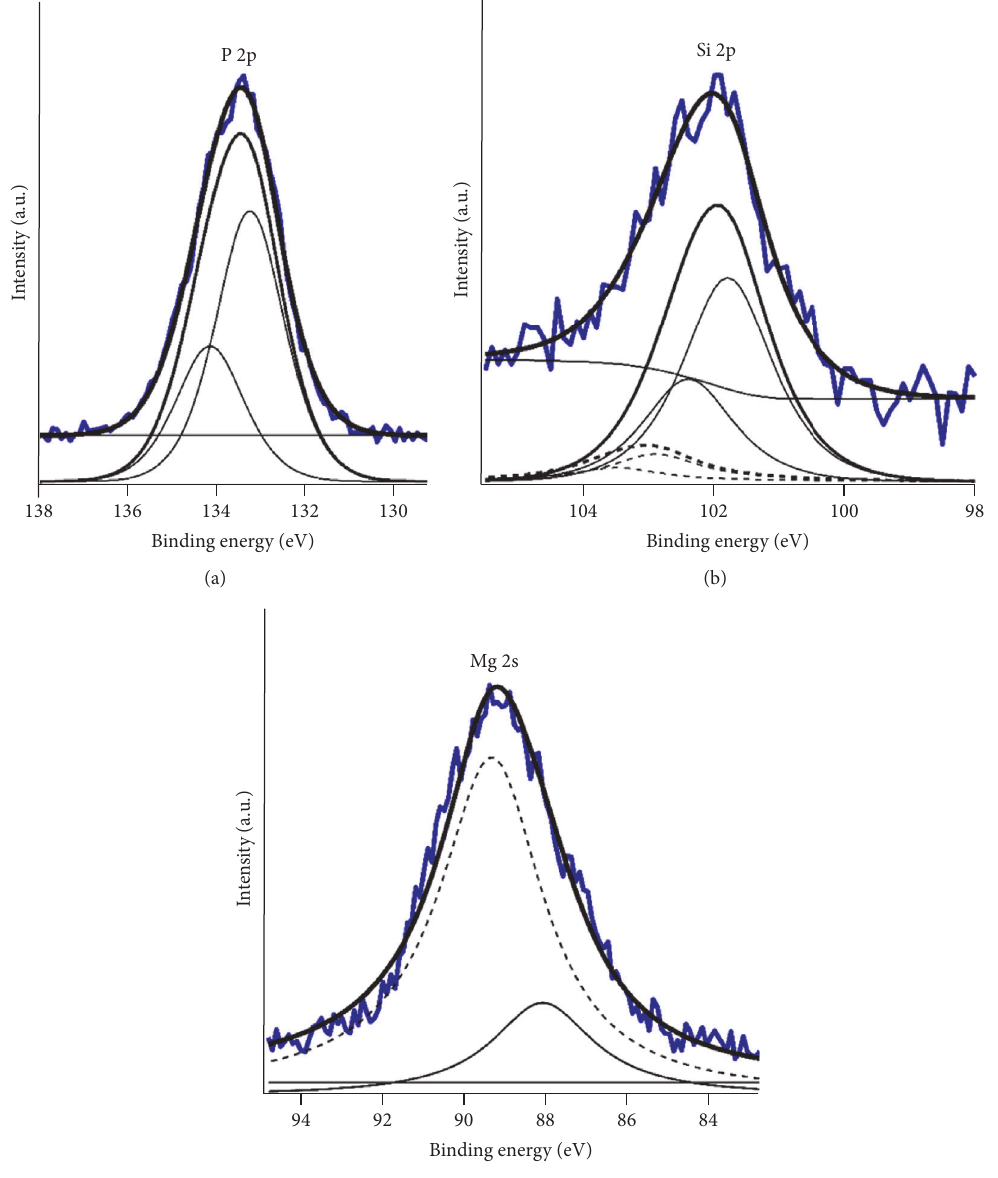
Figure 13: XPS high resolution single peak analysis for the P 2p peak (a), Si 2p peak (b), and Mg 2s peak (c) performed on the PEO treated